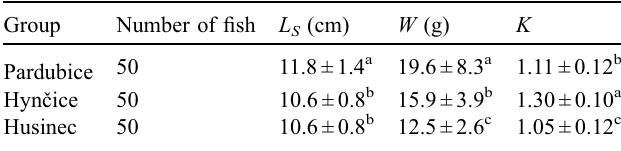
Table 2. Biometric data for tagged grayling before release: mean (±SD) standard length ( L S ), weight ( W ), and Fulton's condition factor ( K ).